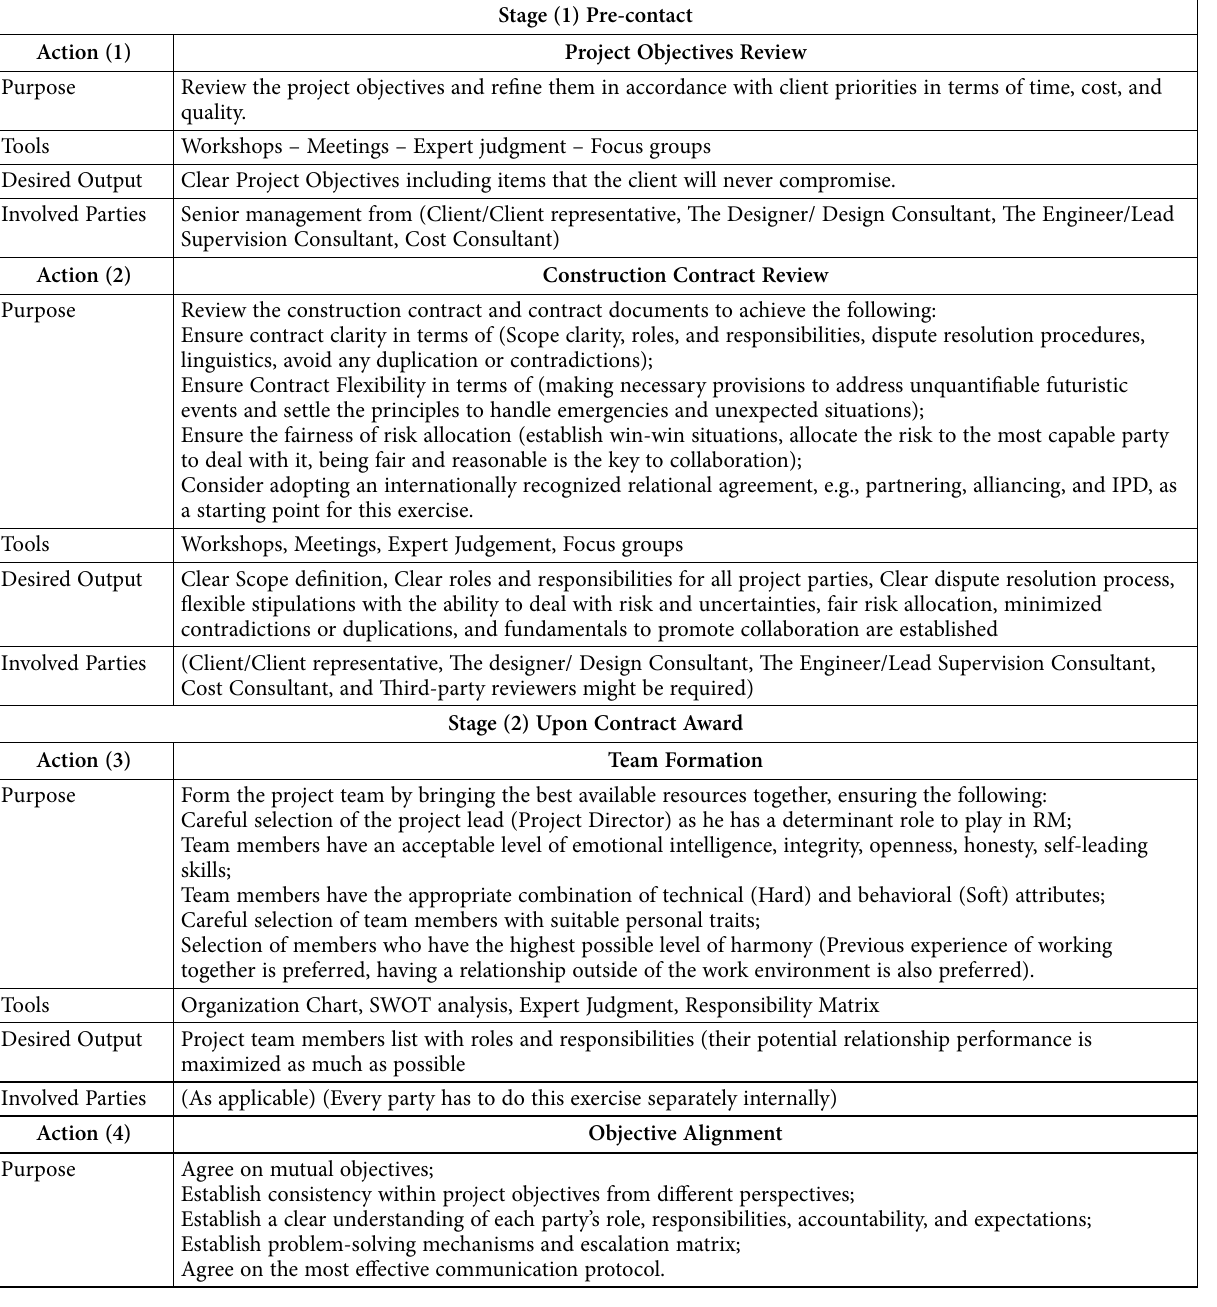
Table 7. Framework operational